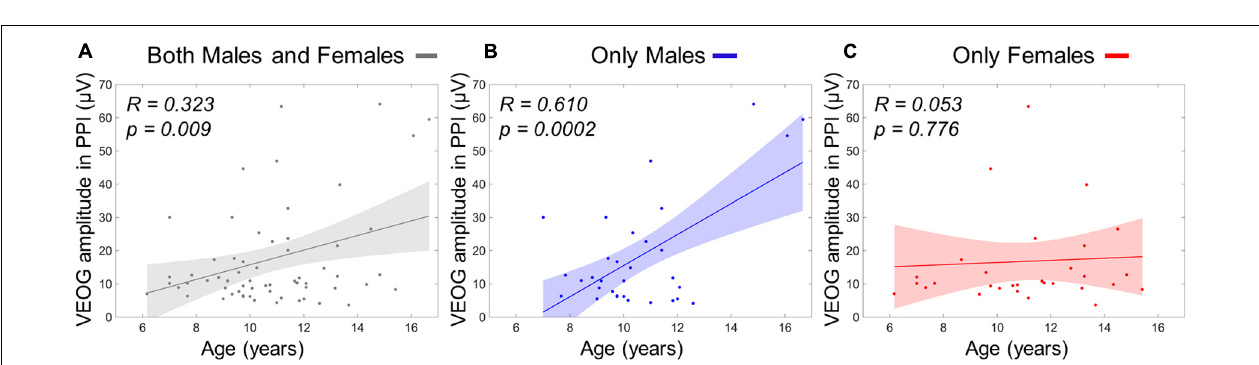
FIGURE 7 | Grand-averaged FDP responses for both groups and conditions. (A) The time course of the WS-FDP responses is illustrated for males (PPI: blue, PPF: green) and females (PPI: red, PPF: orange), respectively, from –30 to 500 ms (time 0 is the startle onset). Color-shaded areas correspond to the time course of the standard error ( ± 1 SE) of the mean. (B) The descriptive statistics (mean and median) of groups/conditions are depicted as scatter boxplots. (C) Topographical maps for averaged FDP during 20–230 ms poststartle.